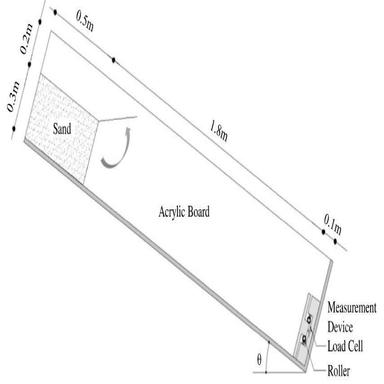
Geometry of flume experiment, after Moriguchi et al. .